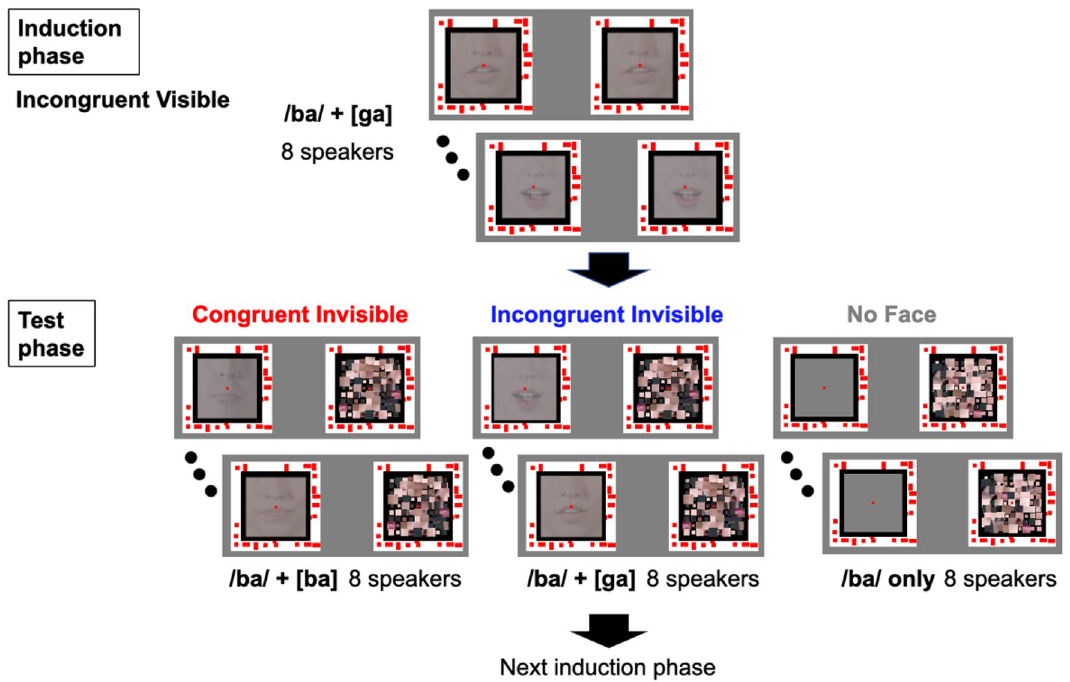
Figure 1. Schematic diagram of experimental stimuli and procedure. In the Induction phase, eight visible McGurk stimuli with different speakers were sequentially presented (once per speaker) to induce the McGurk effects and the aftereffects. In the Test phase, eight invisible face stimuli with different speakers (visual [ga] and visual [ba] for the Incongruent Invisible and Congruent Invisible conditions, respectively) or no stimuli (No Face condition) were sequentially presented with the dynamic mask. In both Induction and Test phase the participants were instructed to judge which syllable they had heard—’ba’, ‘da’, or ‘ga’—and whether they saw the speaker’s face during the trial. Note that the data for the Induction phase were regarded as the baseline, Incongruent Visible